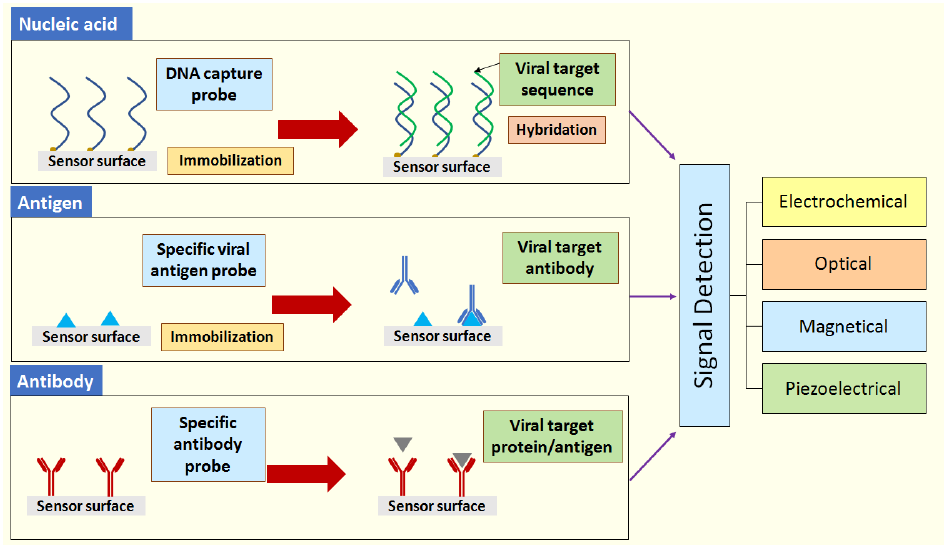
Figure 6. Schematic representation of different biosensors classifications for the detection of SARS and MERS coronaviruses.